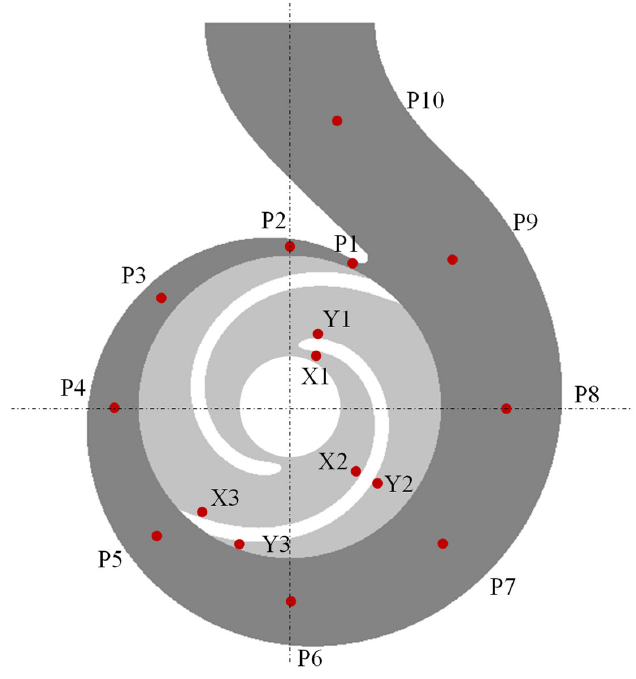
Figure 6. Schematic layout of monitoring points.